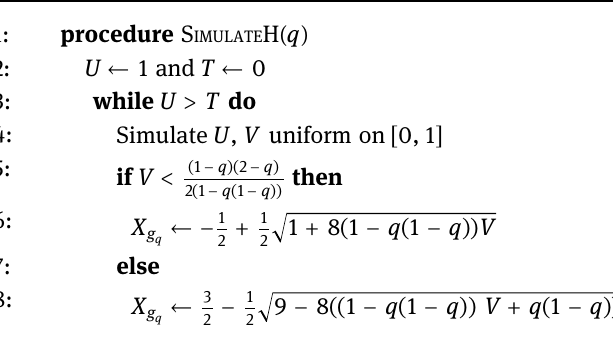
Algorithm 1 . Simulation of